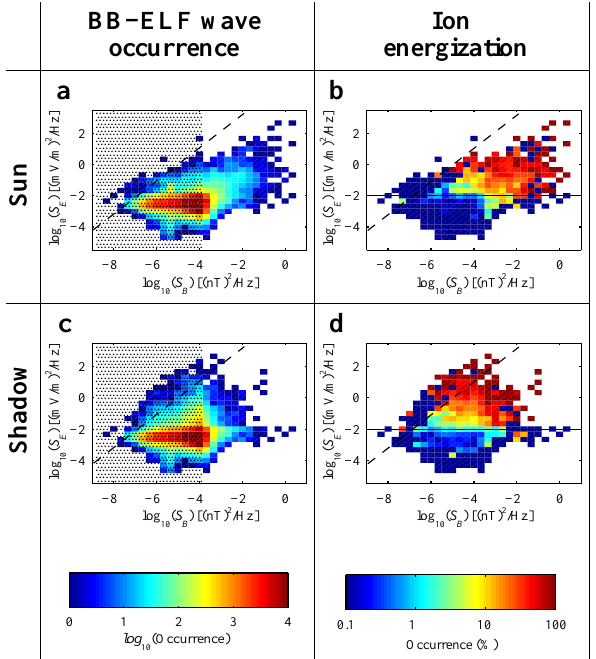
Fig. 6. The number of measurements of BB-ELF waves versus S E and S B at the oxygen gyrofrequency (left) and the probability of detecting energized ions in the presence of these waves (right) above a sunlit (( a ) – ( b )) and dark (( c ) – ( d )) ionosphere. The solid lines at S E = 10 − 2 (mV) 2 /Hz indicate the threshold for the waves being considered important for the ion heating and the dashed lines show the location of S E /S B = c 2 . The shadings indicate the regions where some of the S B data are contaminated with an artificial signal — see the text for